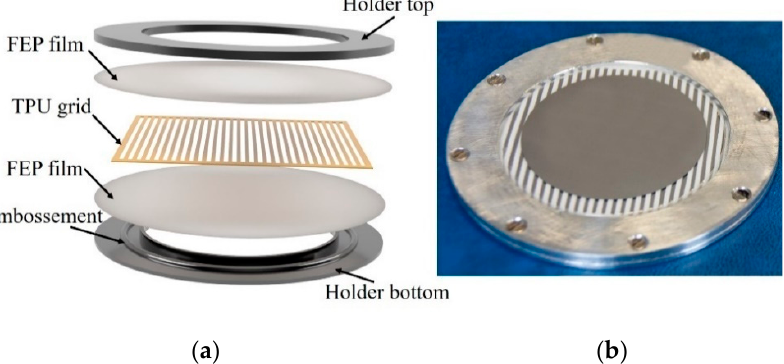
Figure 2. ( a ) Sandwich structure consisting of a 3D-printed Varioshore TPU frame with FEP layers on the top and bottom. All three layers were clamped together using an aluminum holder with tensioning groves as described in the text. ( b ) Photograph of the FEP/TPU-air/FEP device equipped with Al electrodes.